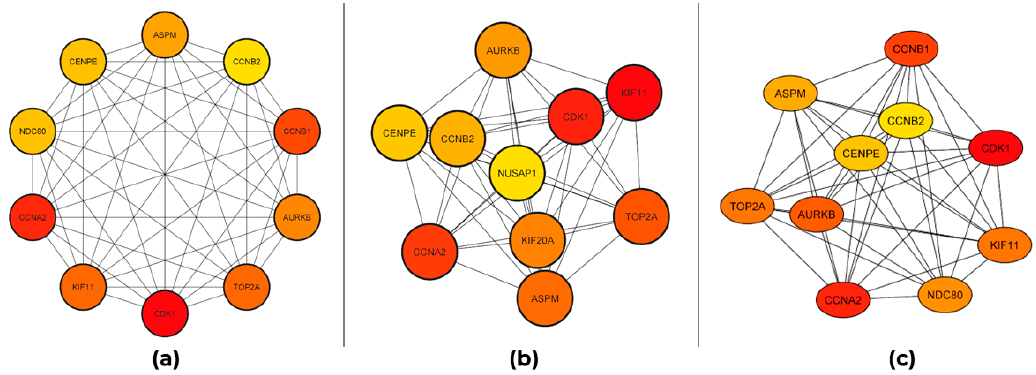
Figure 7. Hub gene network identified and ranked based on ( a ) MNC, ( b ) MCC, and ( c ) node degree. The nodes with red colour have higher MNC, MCC, or node degree in the network. The nodes with colour between red and yellow have medium MNC, MCC, or node degree, and the nodes with yellow colour have the lower MNC, MCC, or node degree in the network.